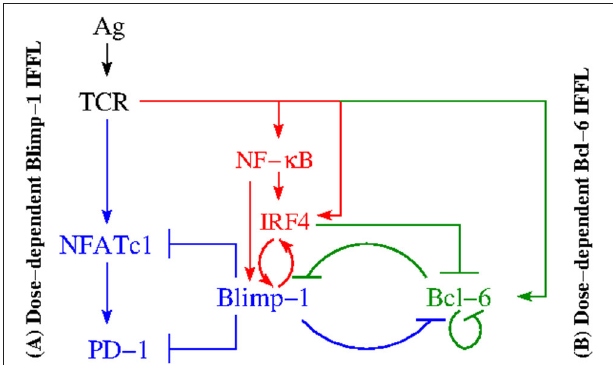
FIGURE 2 | Regulation of PD-1 expression. Two different IFFLs, sharing a common set of species and regulatory activities highlighted in red, are presented. Both IFFLs are activated by the same input (Ag). The left hand side (A) depicts a dose-dependent biphasic activation of PD-1. The elements of the corresponding IFFL are highlighted in blue and red colors. When the input, the Ag dose, increases, the output, the PD-1 level, first also increases but then subsequently decreases. The right hand side (B) corresponds to a dose-dependent activation of Bcl-6. The elements of the corresponding IFFL are highlighted in green and red colors. Over a certain range of input dose, the Ag level, the output, in this case Bcl-6 level, increases but with a subsequent increase in the Ag dose, the Bcl-6 level then